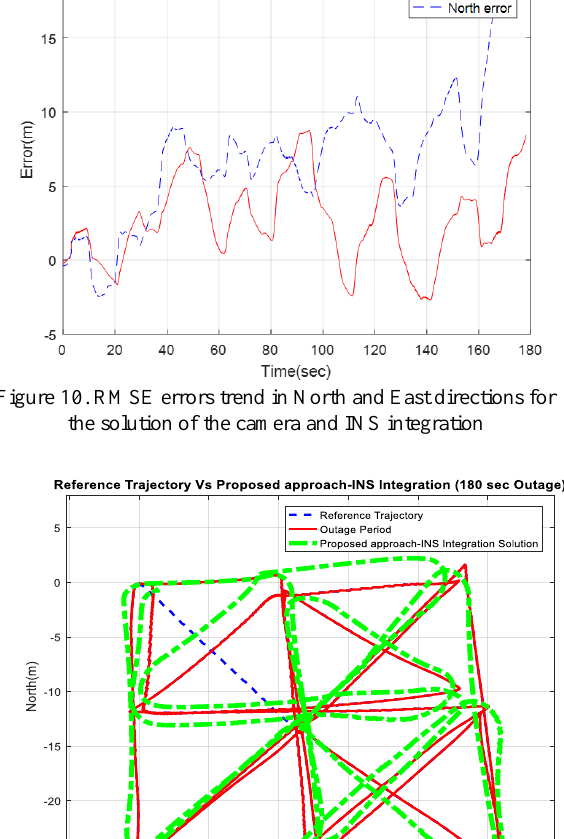
Figure 8. UWB-INS integration North and East errors for 180 seconds of complete GNSS signal outage